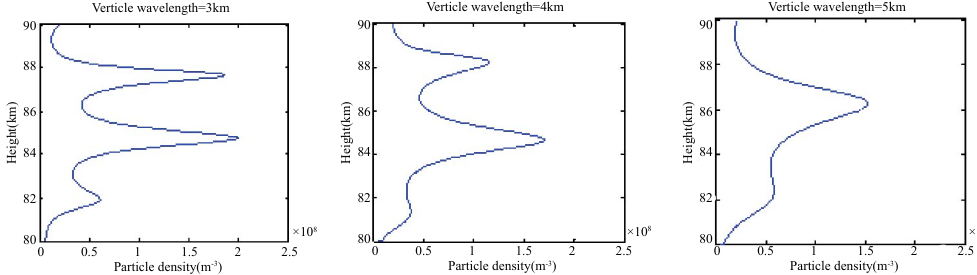
Figure 2. The effect of vertical wavelength on the formation of ice particle layers, the wavelength λ = 3, 4 and 5km, respectively.